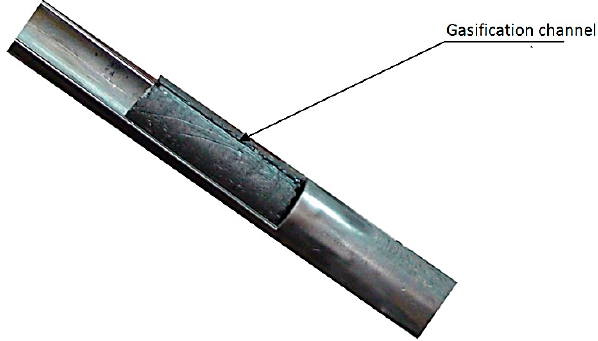
Figure 6. View of the coal sample with the gasification channel.